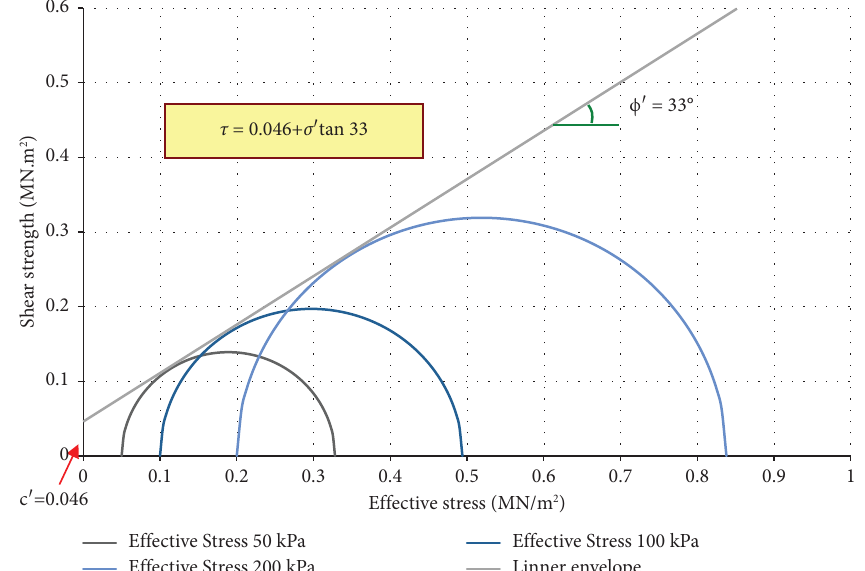
Figure 4: Variation of shear strength against the efective stress-saturated condition CR8 (cement RHA 1: 2, 8% cement content, and 28 days